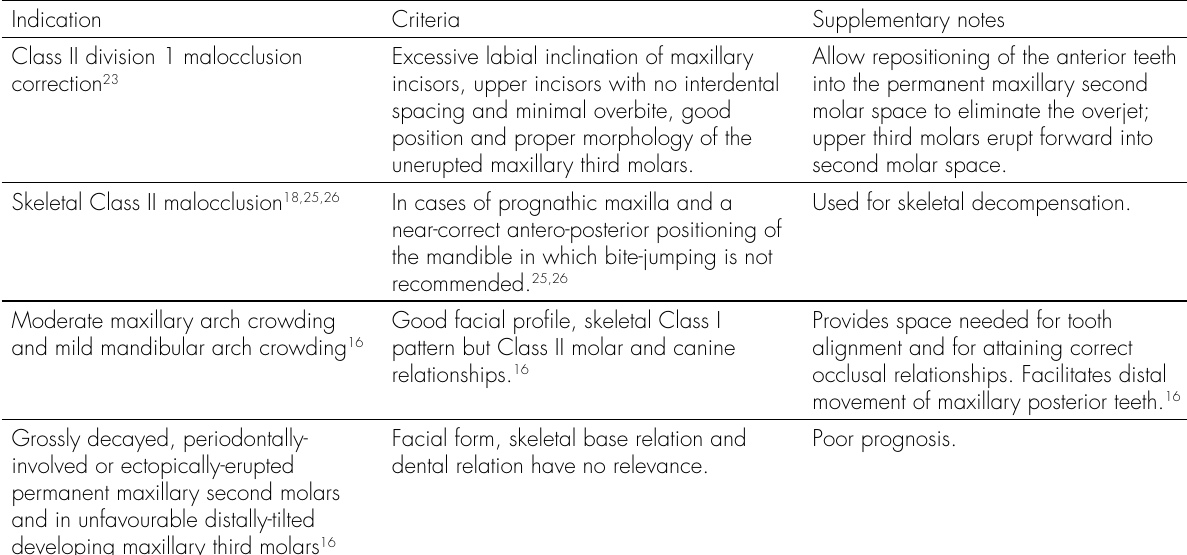
Table II. Indications for permanent maxillary second molar